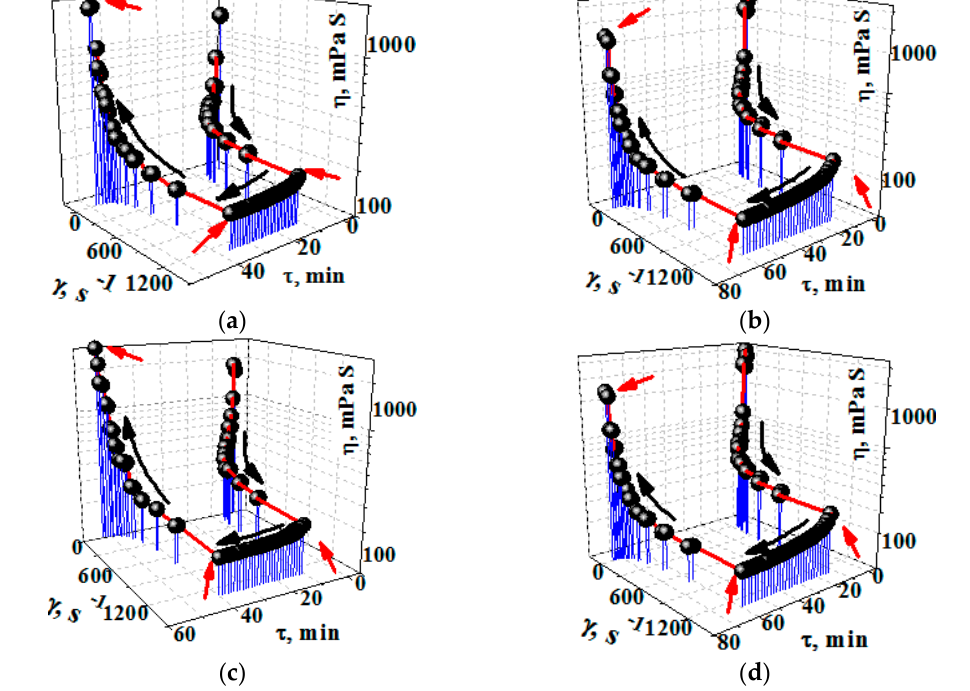
Figure 6. Dependence of effective viscosity on the shear rate over time for hydrophobic silica modified with ( a ) mixture of PDMS-20/DEC; ( b ) neat PDMS-20; ( c ) mixture of PDMS-50/DEC; ( d ) neat PDMS-50 in industrial oil I-40A with the concentration of solid phase 5 wt %.